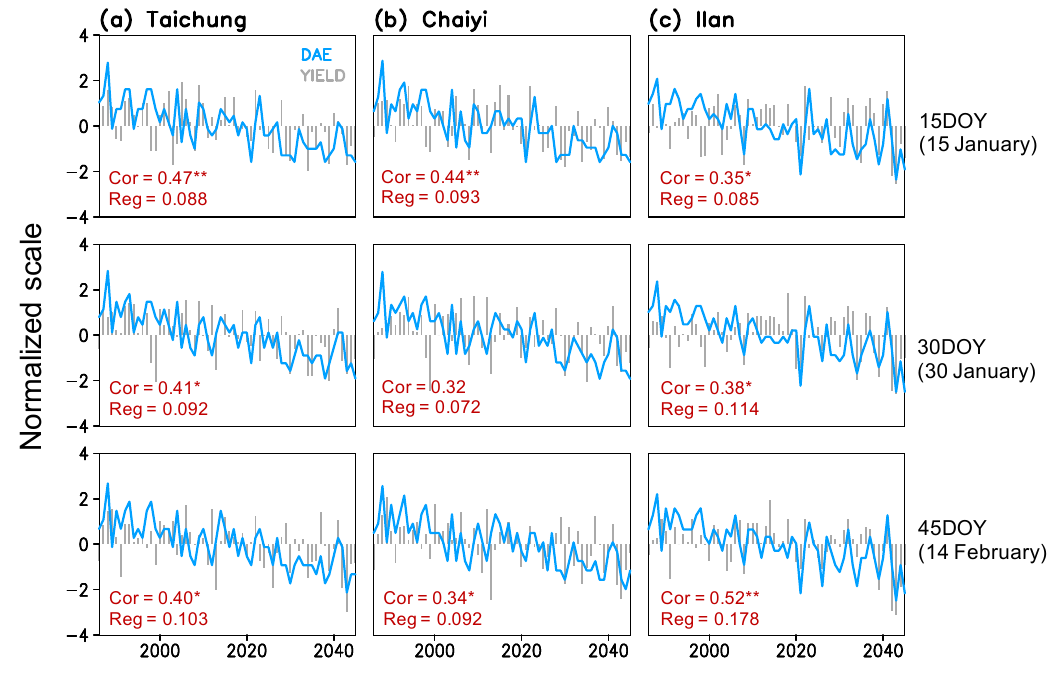
Figure 6. Time series of simulated maturity date (day after emergence; DAE) and yield for three planting dates (15, 30, 45 day of year) constructed for ( a ) Taichung, ( b ) Chaiyi, and ( c ) Ilan; correlation coefficients (Cor) and linear regression coefficients (Reg) between maturity date and yield present in each panel (*, ** indicate significance of the coefficients exceeding 99% and 99.9% confidence interval).